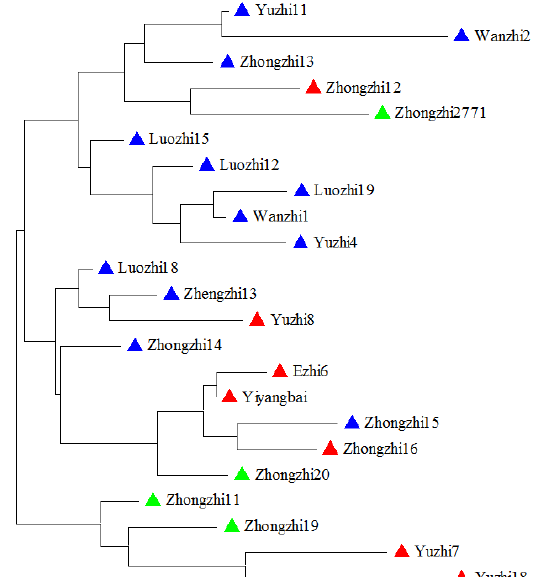
Figure 5. Dendrogram of 23 sesame varieties based on 20 high polymorphism markers. Samples are listed in Table